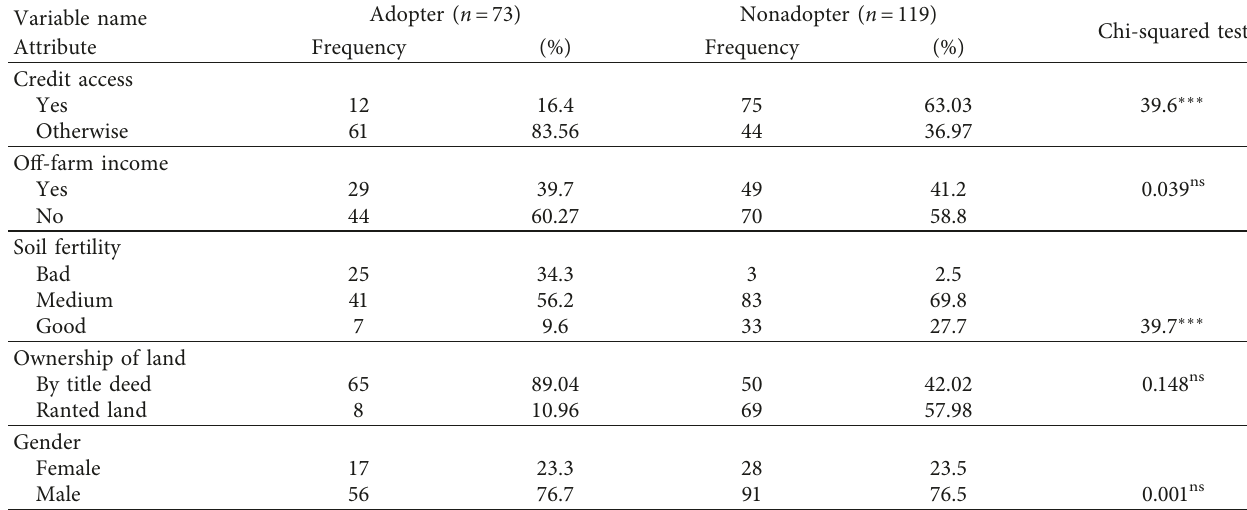
Table 2: Comparison between key socio-economic characteristics by adoption